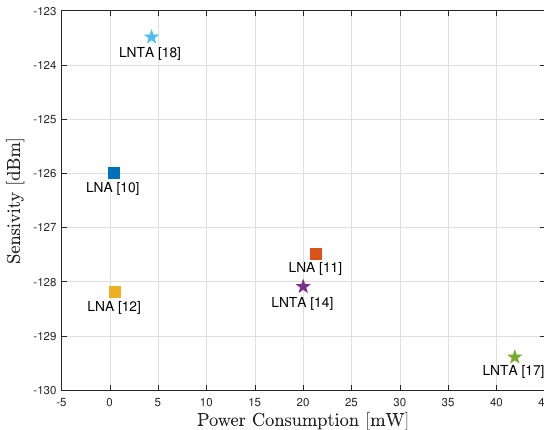
Figure 2. Sensitivity as a function of the power consumption of the RF front-end architectures, with B = 20 MHz and ξ 0 = 0 dB.